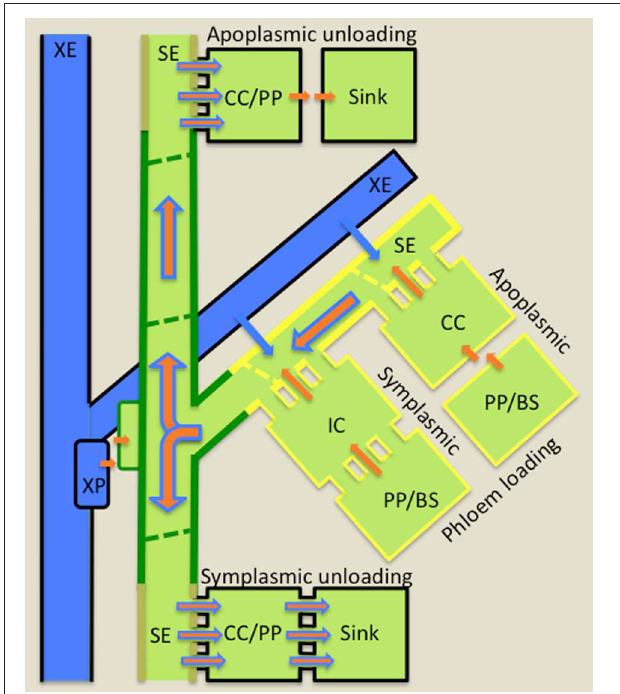
FIGURE 2 | Diagrammatic illustration of cellular pathways of water (blue arrows) and photoassimilate (brown arrows) loading into collection phloem (yellow border) in source leaves, of mineral nutrient exchange from xylem (blue) to transport phloem (green border) at nodes and of resource (water, mineral nutrients and photoassimilates) unloading from release phloem (kaki borders) in sinks. Phloem loading mechanisms are defined according to cellular routes followed by photoassimilates moving from phloem parenchyma (PP) or bundle sheath (BS) cells to intermediary cells (IC; modified companion cells) or companion cells (CC) of collection phloem. Photoassimilate movement may occur from PP/BS cells through interconnecting plasmodesmata (symplasmic loading) to ICs or, in the absence of an adequate plasmodesmal connectivity, photoassimilates are effluxed from PP or BS cells into the cell wall matrix from which they are loaded into adjacent CCs (apoplasmic loading). Thereafter, for either loading mechanism, photoassimilates (primarily sugars) move symplasmically into adjacent sieve elements (SEs) of collection phloem. Accumulation of sugars to high concentrations in SEs causes an osmotic uptake of water from adjacent xylem elements (XE and see blue arrows) to generate large hydrostatic pressures (1–2MPa). These drive a bulk flow of resources (brown superimposed on blue